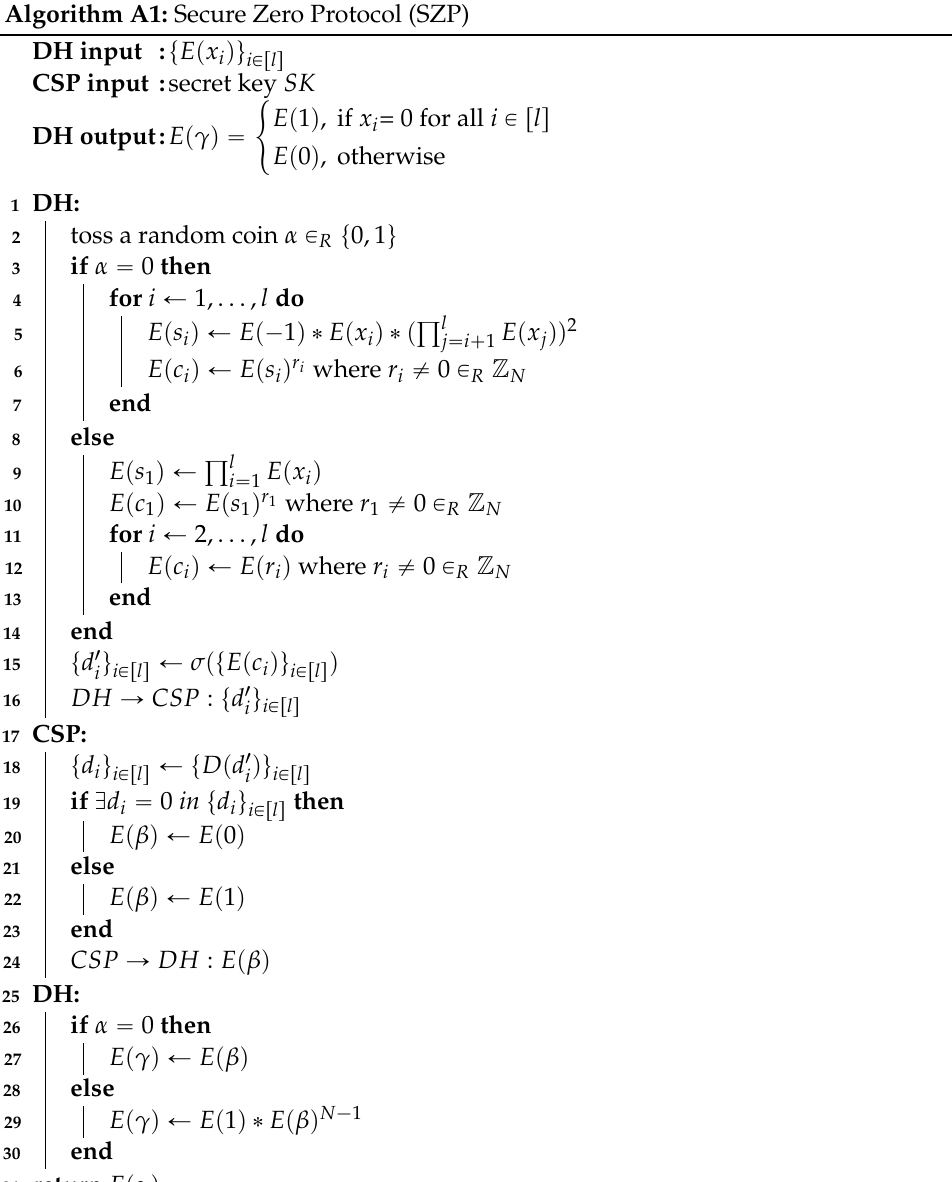
Algorithm A1: Secure Zero Protocol